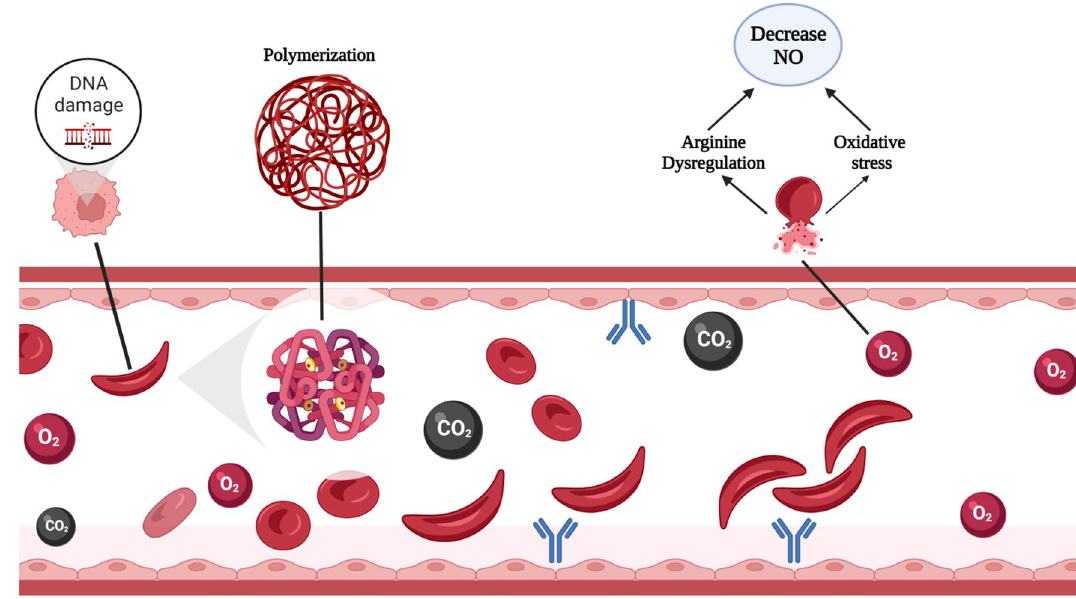
Fig. 2 A representation of arginine dysregulation in blood vessel of SCD patient (Created with BioRender.com)